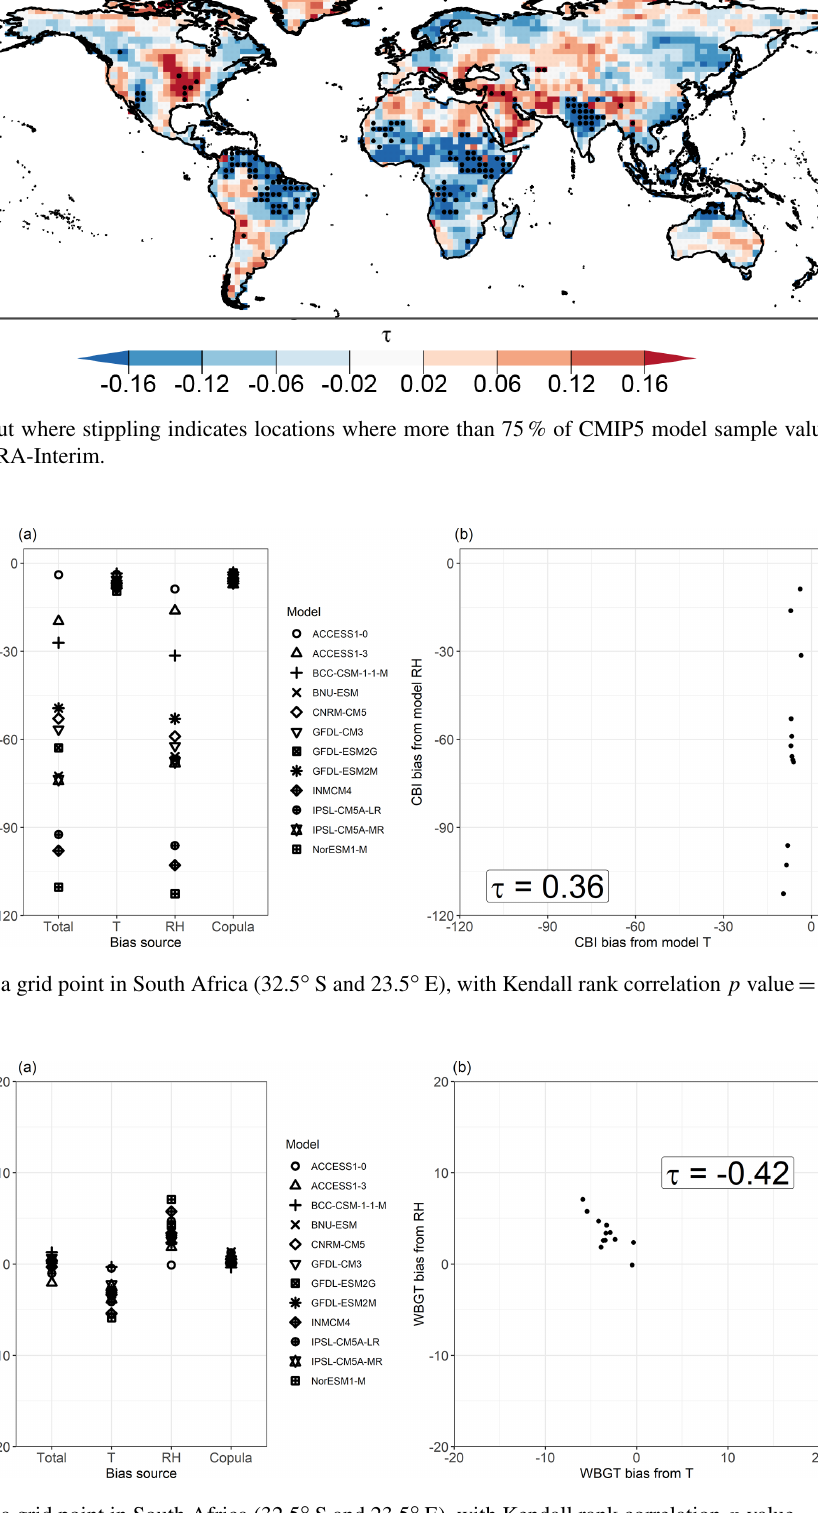
Figure A6. As Fig. 8 for a grid point in South Africa (32.5 ◦ S and 23.5 ◦ E), with Kendall rank correlation p value =